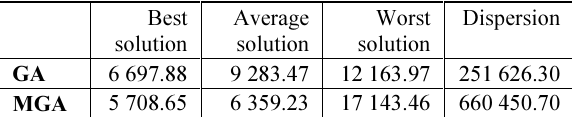
Table 6. Statistical indicators of solutions